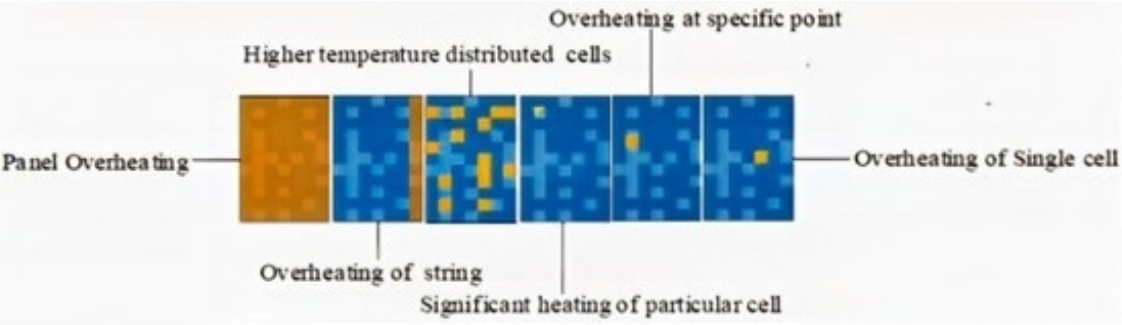
Figure 12. Schematic diagram of infrared images and possible defects [8].